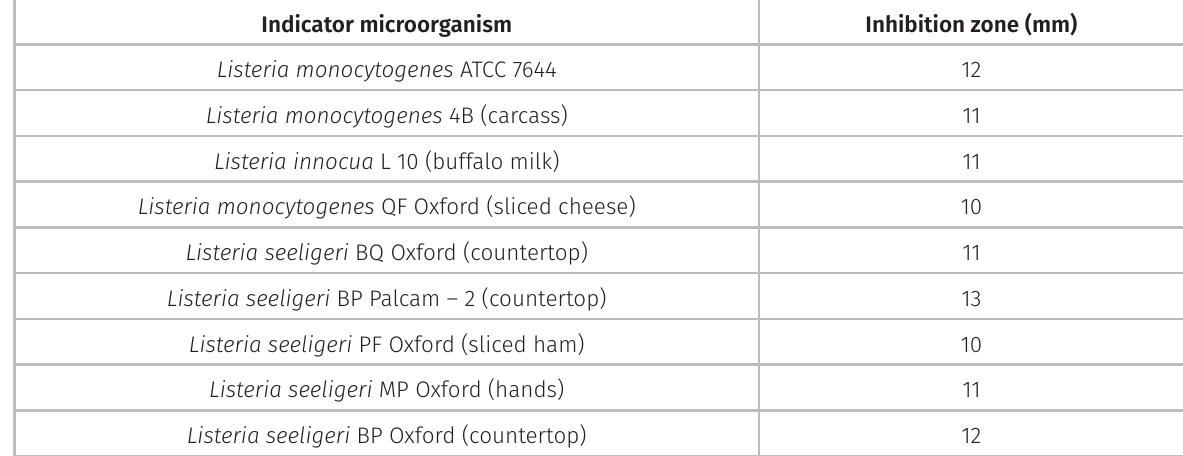
Table III. Spectrum of action of the partially purified antimicrobial substance according to the inhibition zone